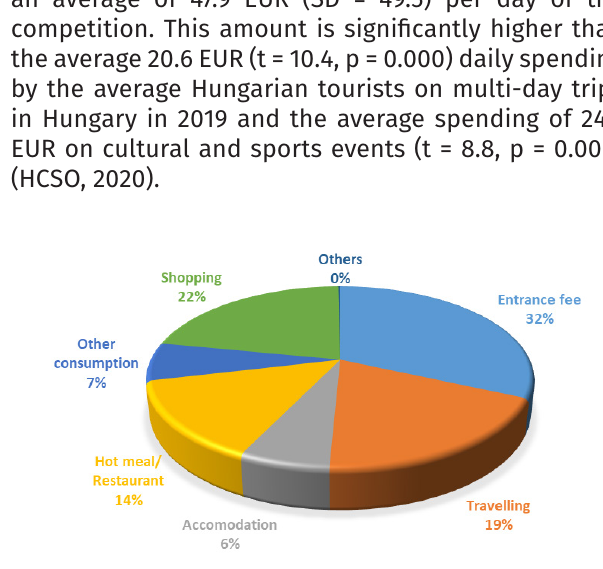
Figure 1. Distribution of Hungarian Spectators’ Expenditure